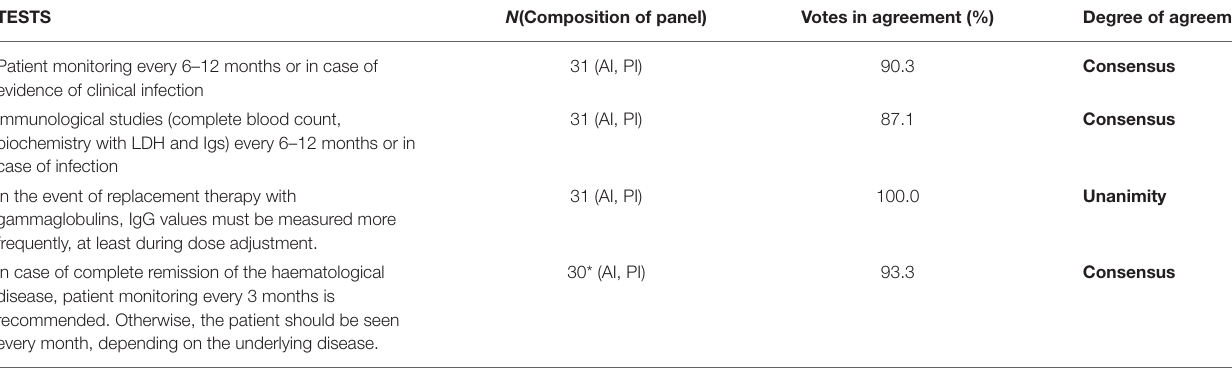
TABLE 5 | Minimum tests to be performed during monitoring of the patient with ID and haematological symptoms.